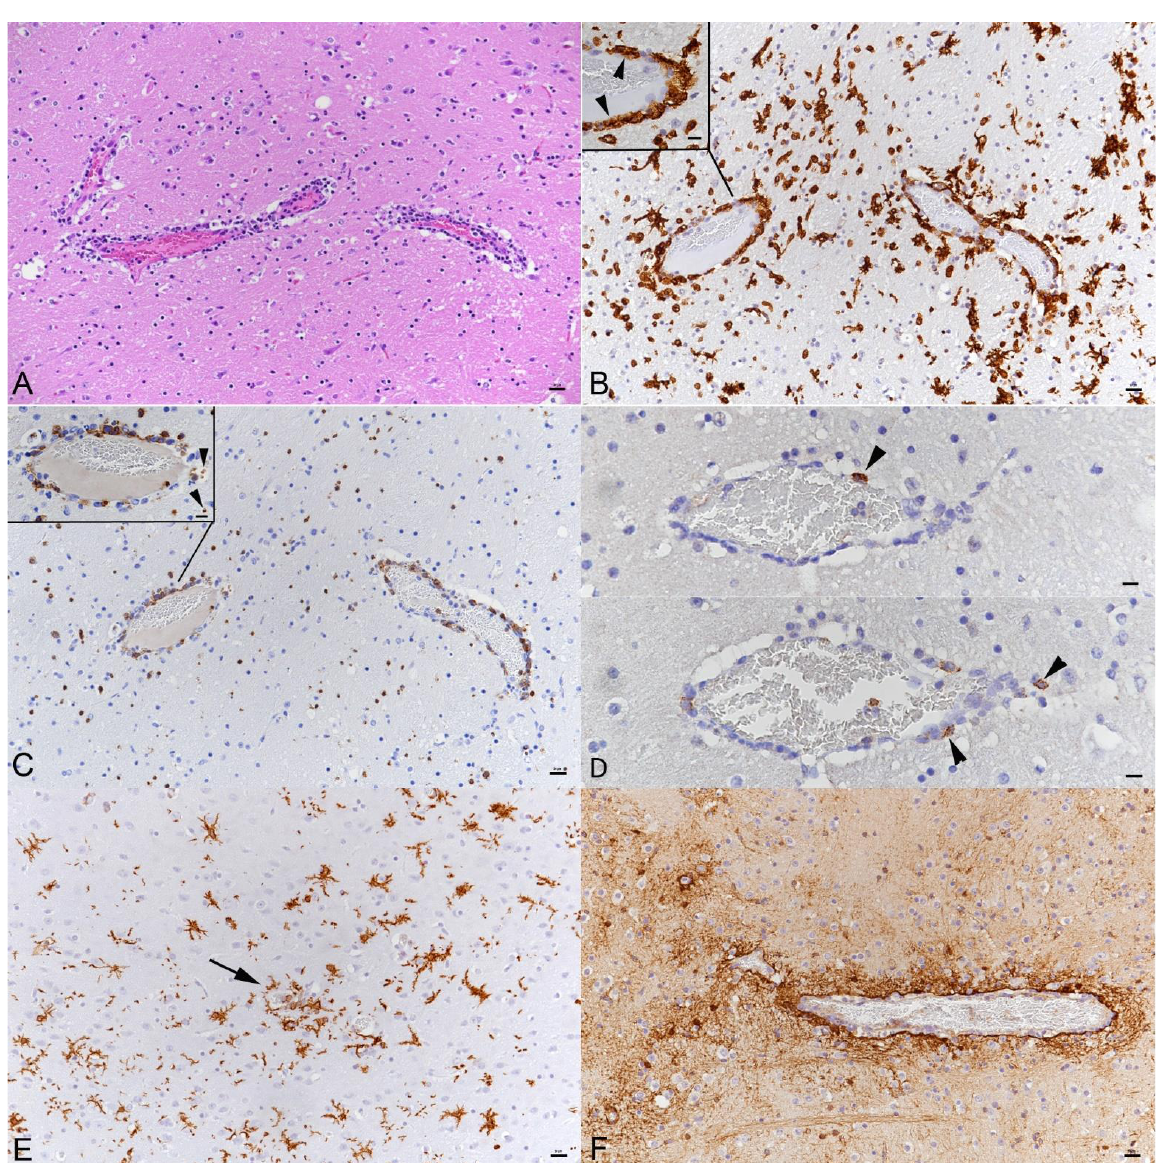
Figure 4. Brain, K18-hACE mouse, day 7 post-intranasal SARS-CoV-2 Pango lineage B infection (10 4 PFU) after initial infection with IAV (10 2 PFU IAV strain A/X31). ( A ) Brain stem with moderate (peri)vascular leukocyte infiltration and mildly increased cellularity in the parenchyma. HE stain. ( B ) Macrophages (Iba1+) dominate in the (peri)vascular infiltrate (inset: arrowheads) and the sur- rounding parenchyma exhibits microglial activation (Iba1+ stellate shaped cells). ( C ) T cells (CD3+) are also abundant in the (peri)vascular infiltrates and are found infiltrating the adjacent paren- chyma. Inset: vessel with infiltrating T cells; some are degenerate (arrowheads). ( D ) Neutrophils (Ly6G+; top, arrowhead) and B cells (CD45R/B220+; bottom, arrowheads) are very rare in the infil- trates. ( E ) Brain stem with activated microglial cells (Iba1+) and small microglial nodule (arrow). ( F ) Staining of astrocytes (GFAP+) shows hypertrophied astrocytes around a vessel with a mild peri- vascular infiltrate. ( B – F ) immunohistochemistry, hematoxylin counterstain. Bars = 20 μm . 3.4. There Is No Evidence of Viral Infection of Glial Cells, Endothelial Cells or Leukocytes or of Neuronal Cell Death, Axonal Damage or Demyelination in Association with SARS-CoV-2 Infection, but of Apoptotic Death of Endothelial Cells and Immune Cells